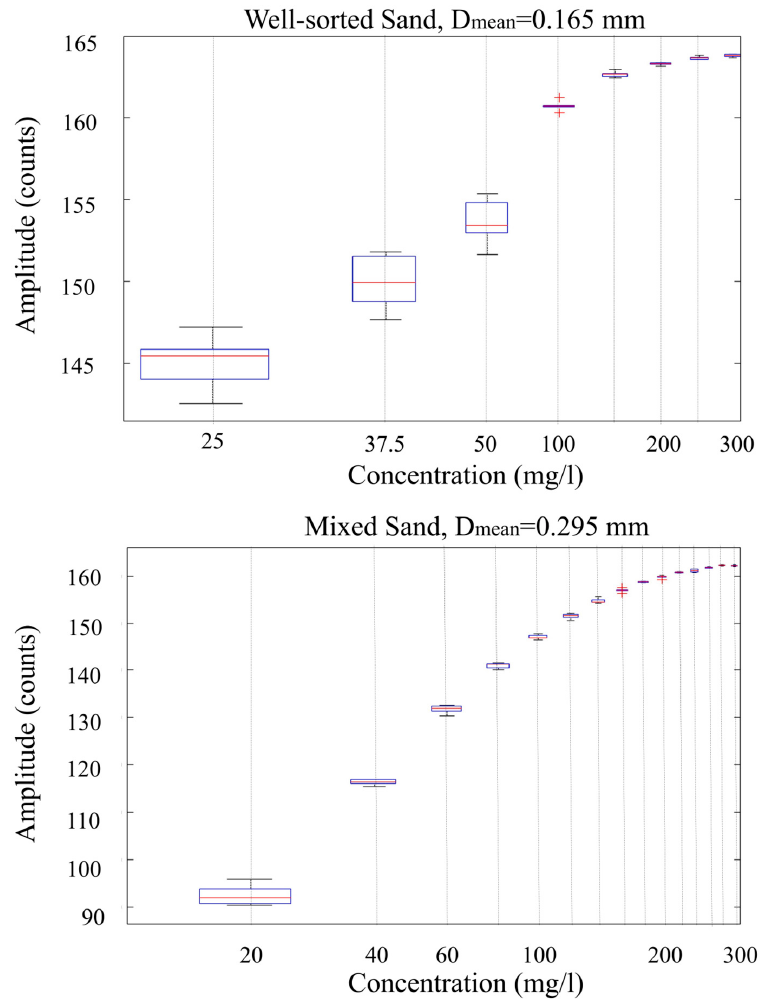
Figure 3. Raw backscatter amplitude vs. concentration for two experiments with well-sorted ( top panel ) and mixed ( lower panel ) sand samples. Each case was repeated six times for each tested concentration (the central mark is median, the edges of each box are the 25th and 75th percentiles, and the whiskers show extremes).